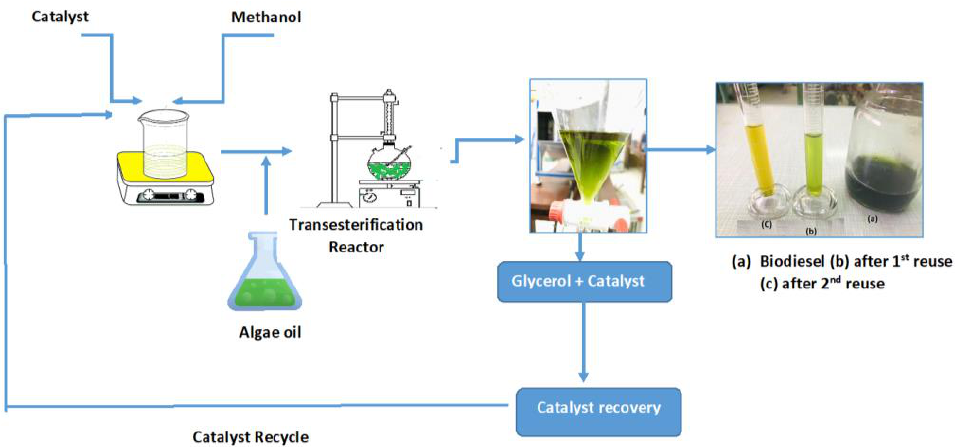
Figure 8. Transesterification of algal oil to biodiesel. Reprinted with permission from Ref. [85]. 2020, American Chemical Society.